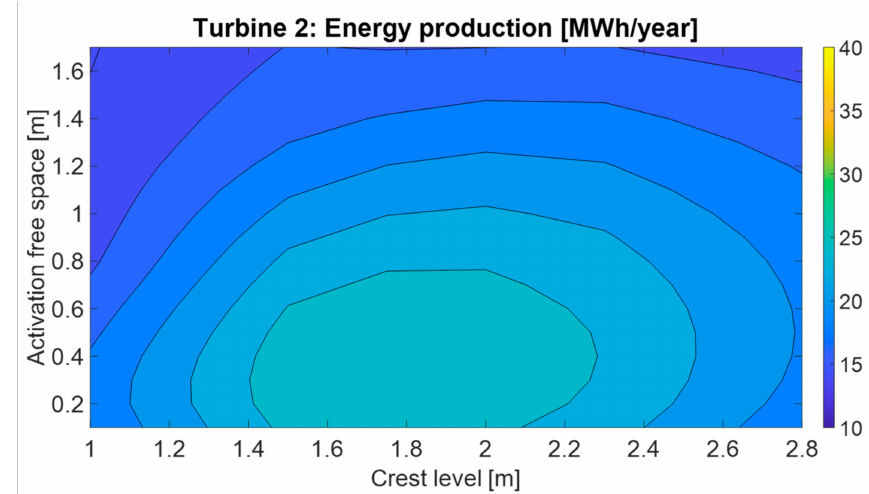
Figure 8. Energy produced by Turbine 2 as a function of the activation free space f a and the crest level h cr .